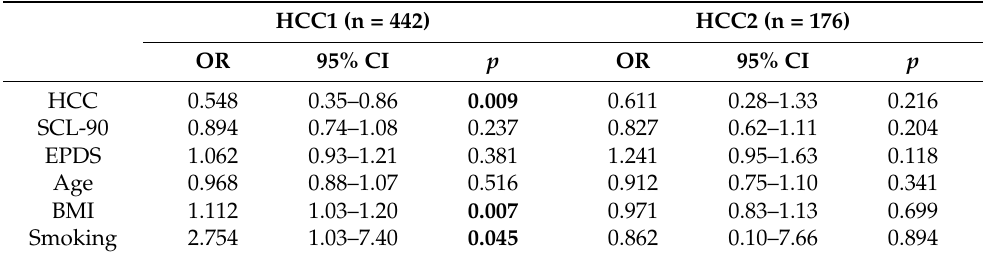
Table 4. Final model presenting odds ratios (OR) with 95% confidence intervals (95% CI) and p -values on HCC for high dental anxiety adjusted for anxiety (SCL-90) and depressive (EPDS) symptoms, age, BMI, and smoking. HCC1 (n = 442) HCC2 (n = 176) OR 95% CI p OR 95% CI p HCC 0.548 0.35–0.86 0.009 0.611 0.28–1.33 0.216 SCL-90 0.894 0.74–1.08 0.237 0.827 0.62–1.11 0.204 EPDS 1.062 0.93–1.21 0.381 1.241 0.95–1.63 0.118 Age 0.968 0.88–1.07 0.516 0.912 0.75–1.10 0.341 BMI 1.112 1.03–1.20 0.007 0.971 0.83–1.13 0.699 Smoking 2.754 1.03–7.40 0.045 0.10–7.66